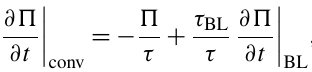
Figure 3. Total (red solid), convective (red dashed), and observed total precipitation rates (mm per hour) with the GF scheme using the TWP-ICE